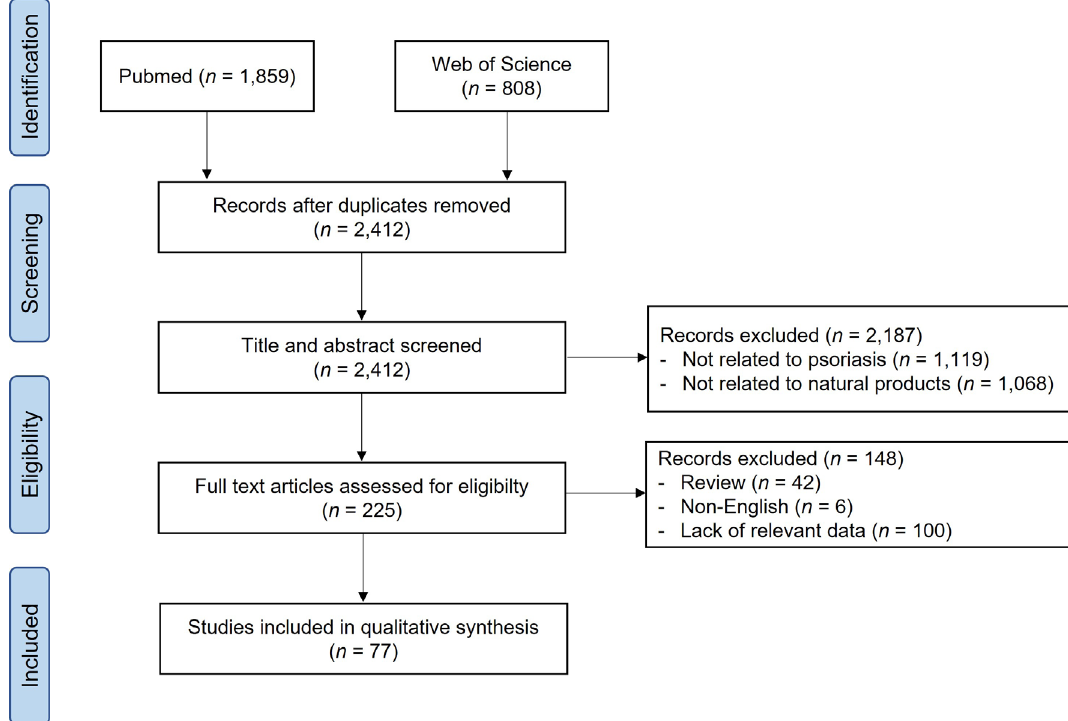
Figure 1. Flow chart of study